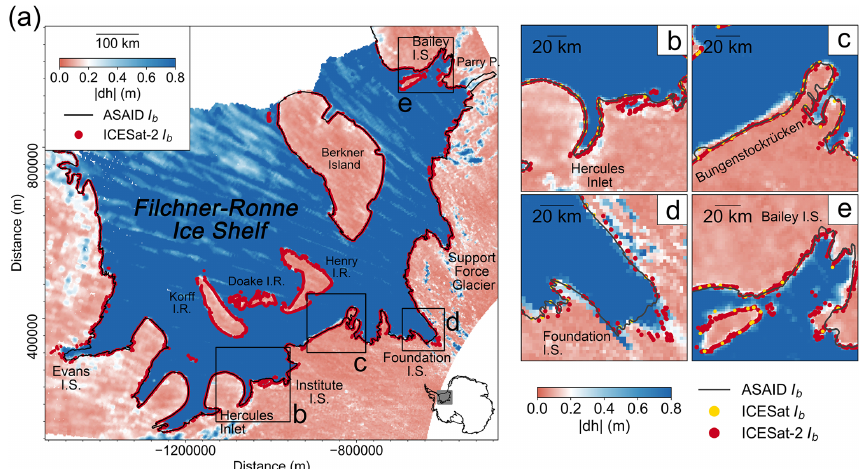
Figure A1. (a) Spatial distribution of the absolute elevation change at ICESat-2 crossovers per 2km grid cell across the Filchner–Ronne Ice Shelf overlaid with ICESat-2-derived break in slope (Point I b ); the four black boxes denote the individual regions plotted in (b) – (e) . (b) Hercules Inlet, (c) Bungenstockrücken, (d) Foundation Ice Stream, (e) Bailey Ice Stream. In all subplots, the ICESat-2-derived breaks in slope (Point I b ) are shown as red dots. The ICESat-derived Point I b locations are shown as the yellow dots. The ASAID Point I b is shown as the black line (Bindschadler et al., 2011).